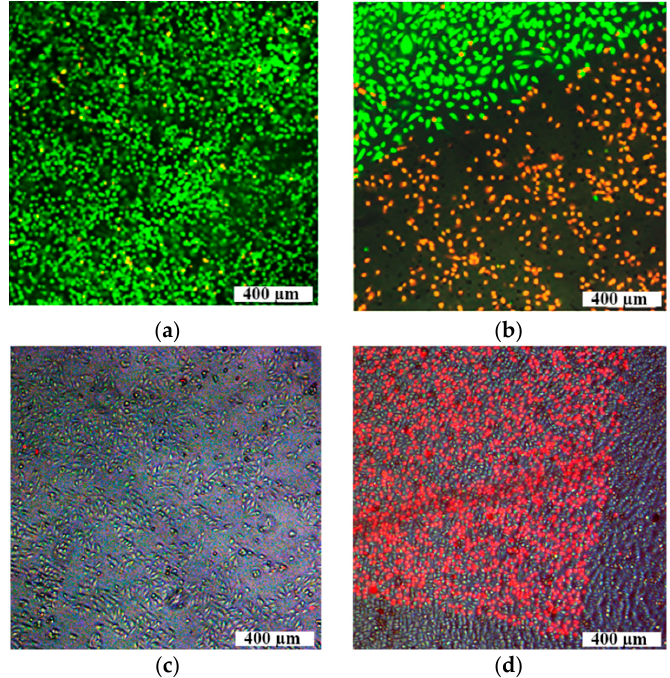
Figure 11. Upper row: the fluorescent images of cells stained by Calcein AM (green color) and PI (red color) irradiated by ns-laser generated laser pulses at 532 nm with a pulse duration of 5 ns, repetition rate 20 Hz, maximal pulse energy 0.1 mJ, mean power 2 mW: samples of pure cells ( a ); cells incubated with AuNSps under NS-laser treatment ( b ); Lower row: combination of bright-field and fluorescent images of cell samples irradiated by the scan-NS-laser with a wavelength of 1064 nm, pulse duration of 4 ns, repetition rate up to 20 kHz, mean power 20 W, and single pulse energy of 0.1 µJ: without AuNSts ( c ); with AuNSts ( d ). PI-perforated cells stained red color.